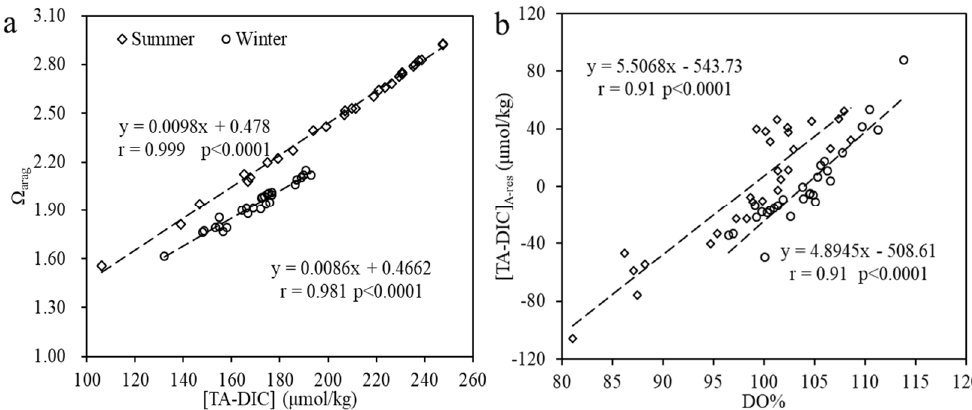
Figure 5. Scatterplots of seawater surface Ω arag vs. [TA-DIC] ( a ) and [TA-DIC] A-res vs. DO% ( b ) in JZB during summer (28 June 2017) and winter (17 January 2017). [TA-DIC] represents the difference between TA and DIC. [TA-DIC] A-res represents the [TA-DIC] A values after the deduction of the effects from temperature and mixing processes according to Equation (4). [TA-DIC] A represents the difference between the [TA-DIC] value of the station and the average [TA-DIC] value during one cruise.